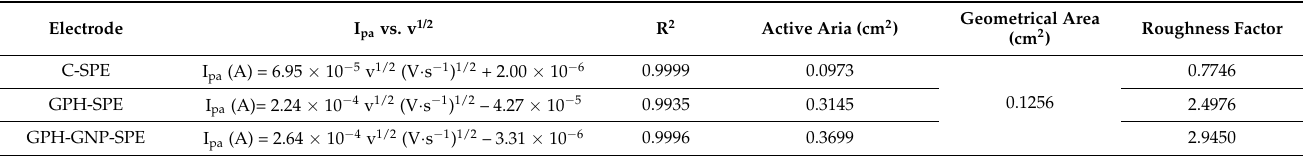
Table 2. Ipa vs. v 1/2 linear regression equations, determination coefficients, active surface areas, geometrical areas, and the roughness factors of all the SPEs